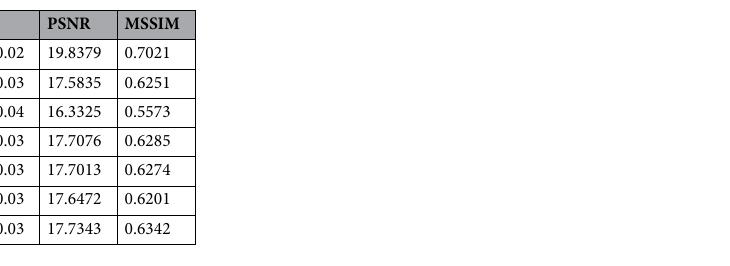
Table 2. PSNR and MSSIM for the test images.